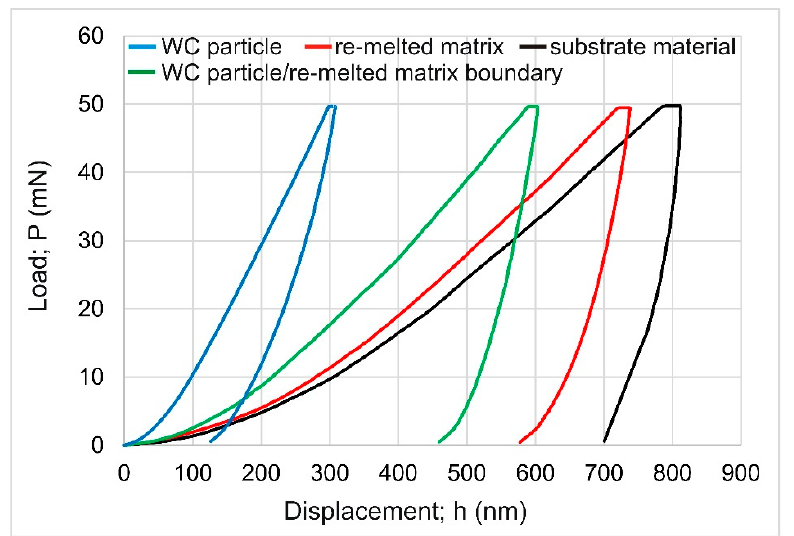
Figure 11. Load-displacement curves recorded for Inconel ® 600-alloy laser-alloyed with WC particles/Inconel ® 625 using a laser beam power of 1.3 kW.